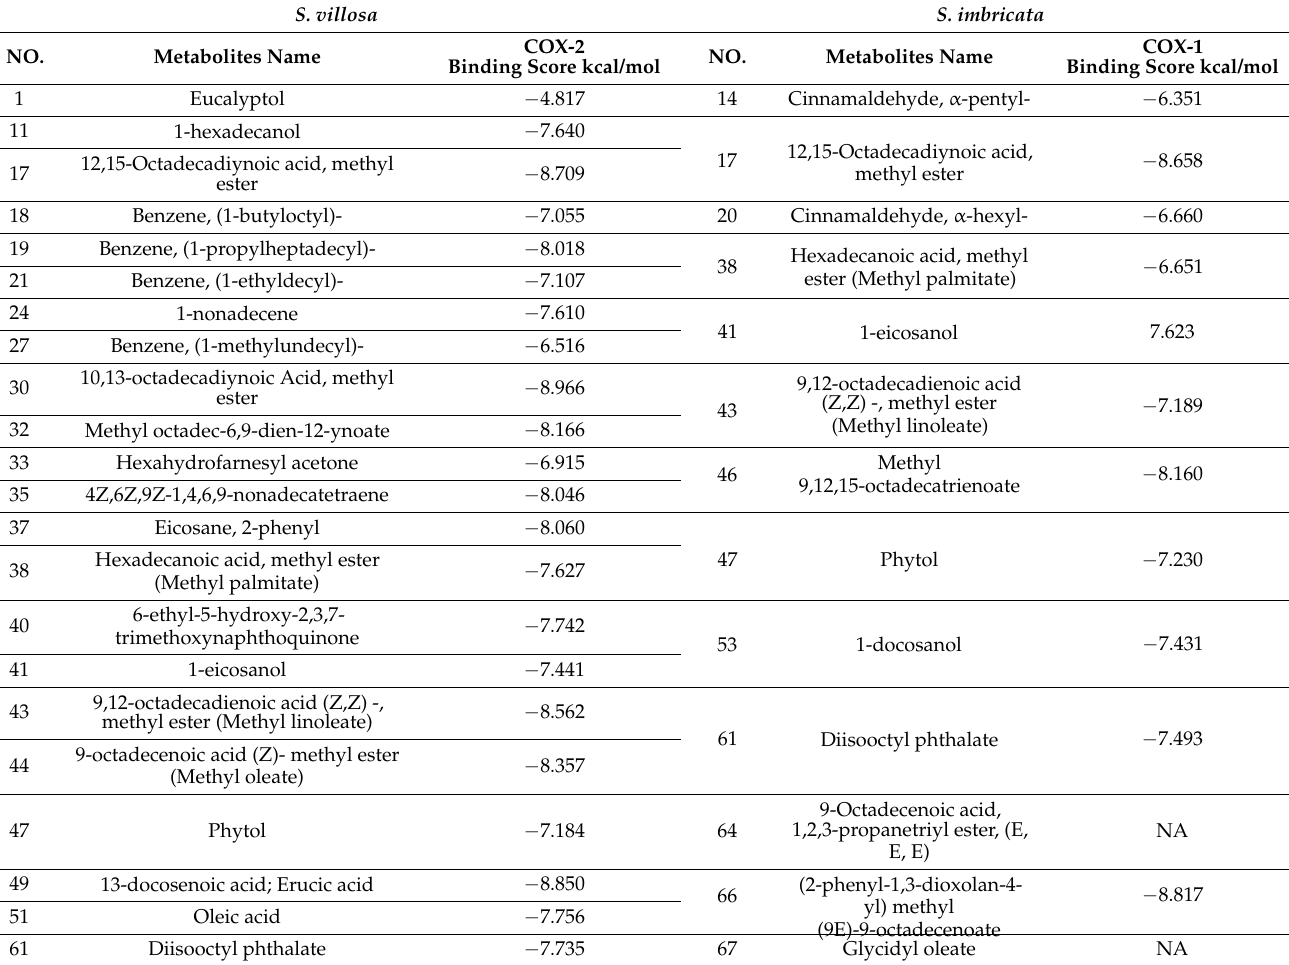
Table 3. Binding scores of S. villosa and S. imbricata identified metabolites docked into active sites of COX-2 and COX-1 enzymes,